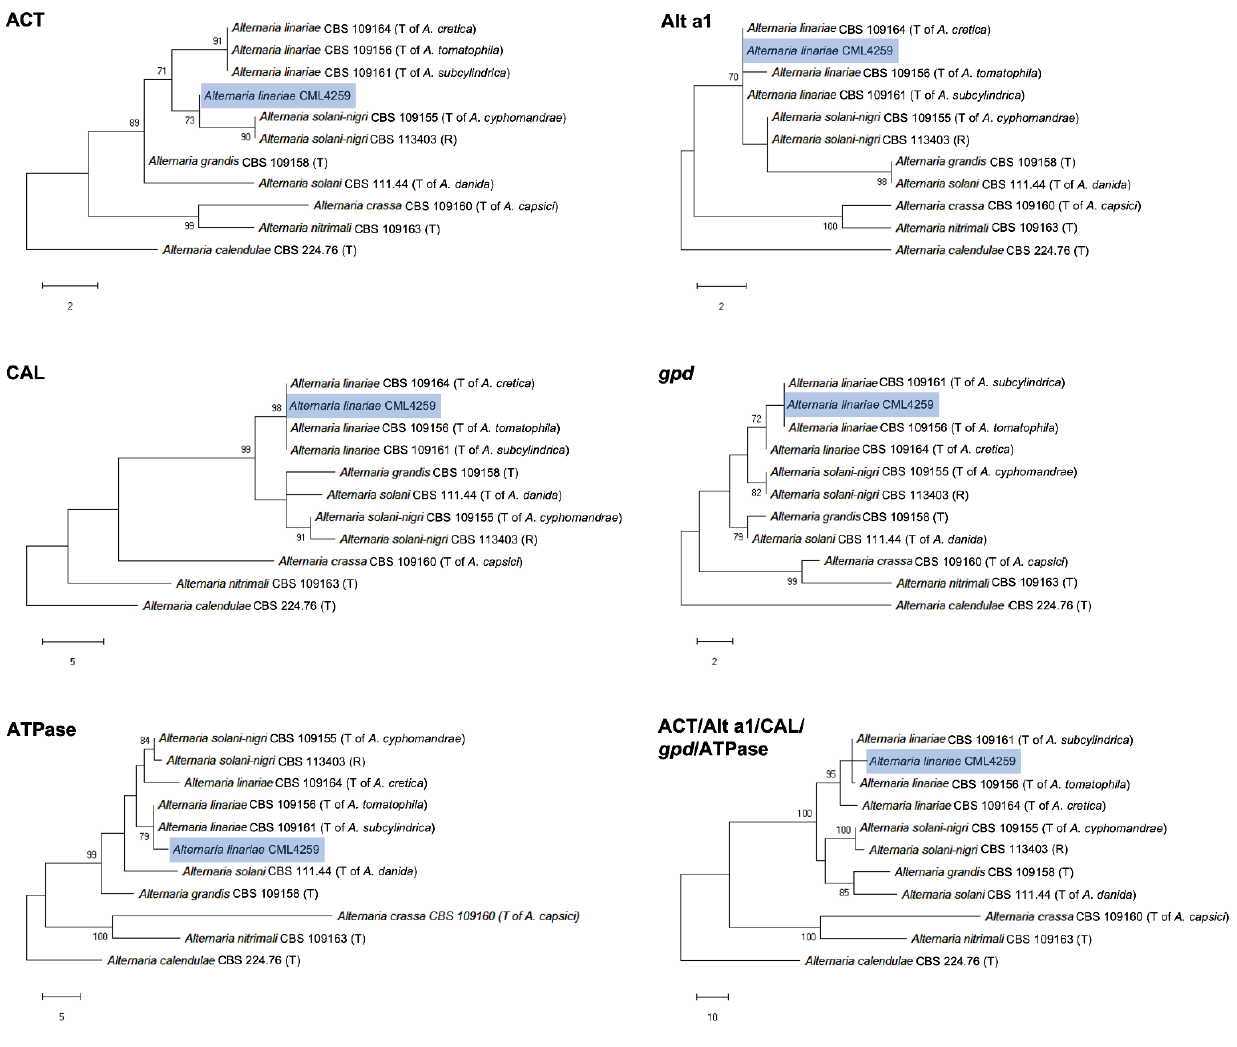
Figure 1. Maximum parsimony phylogenetic tree of Alternaria sp. The isolate from this study is indicated in bold. Bootstrap values ≥ 70% are displayed in the tree’s internodes. Alternaria calendulae CBS 224.76 was used as an outgroup. T: ex-type strain; R: representative strain. Table 2. Effect of essential oils on mycelial growth inhibition (%) of Alternaria linariae . Treatment Thyme essential oil Lemongrass essential